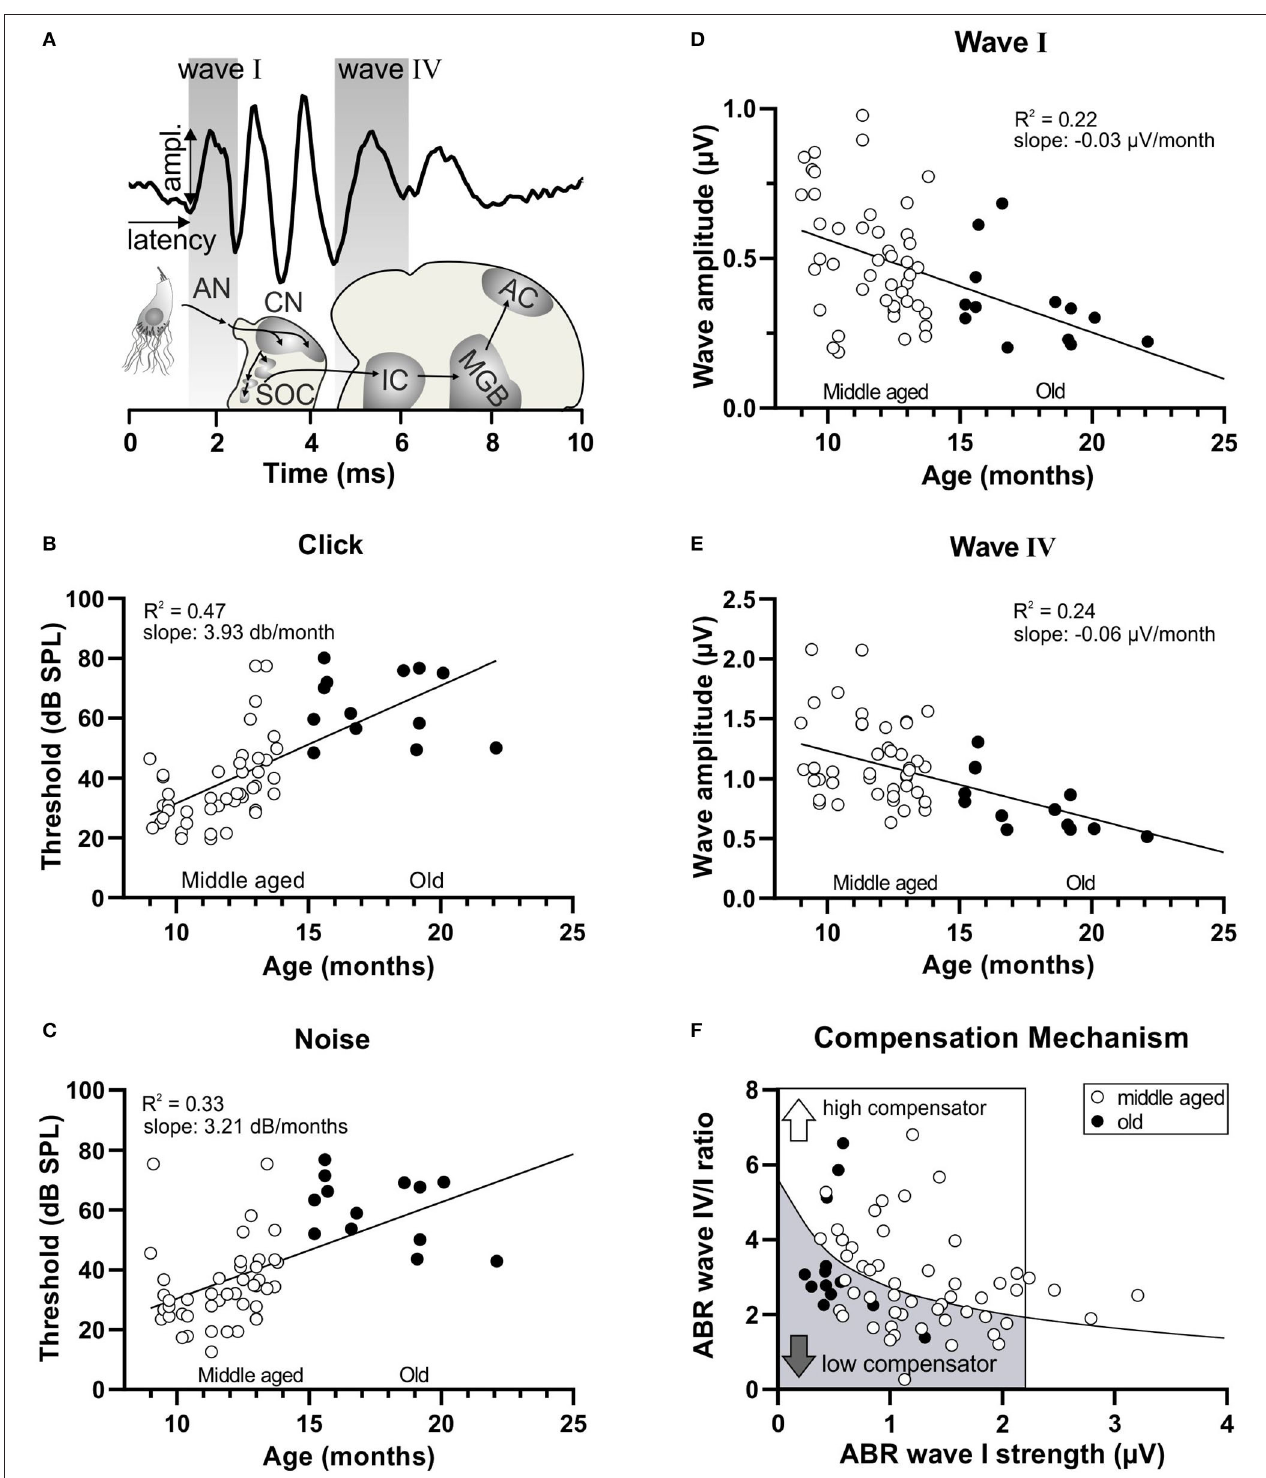
FIGURE 1 | Decrease in hearing function over age and subsequent subdivision by the compensation mechanism. (A) Schematic drawing of the auditory pathway and stimulus-evoked deflections of ABR waves correlated with anatomical structures. AN, auditory nerve; CN, cochlear nucleus; SOC, superior olivary complex; IC, inferior colliculus; MGB, medial geniculate body; AC, auditory cortex. (B) In a homogenous group of aging animals (white circles < 15 months, middle aged; black circles > 15 months old), increasing age was significantly correlated with an increasing threshold in response to click stimuli and (C) noise stimuli. (D) In addition, increasing age was significantly correlated with a decreasing amplitude of ABR wave I (E) and ABR wave IV. (F) A schematic diagram representing animals with reduced ABR wave I (inside the box; ABR wave I < 2.19 µ V) subdivided by the black regression line, depending on their central compensation capacity into low compensators (the lower wave IV/I ratio) and high compensators (the higher wave IV/I